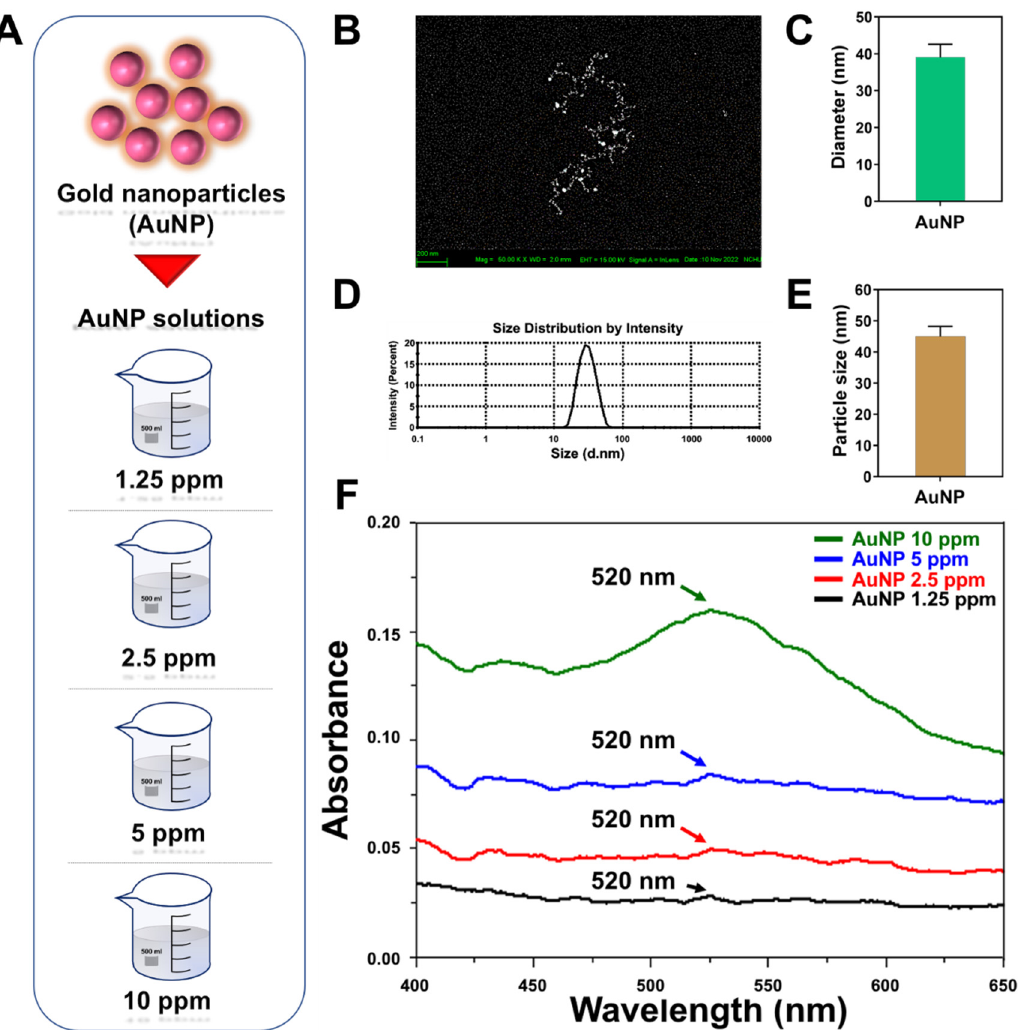
Figure 1. AuNP characterization. ( A ) The brief procedure to prepare various concentrations of AuNP solutions. The concentrations included 1.25, 2.5, 5 and 10 ppm. ( B,C ) The shape of the AuNPs was visualized by SEM, while the scale bar was set as 200 nm. The diameter of the AuNPs was quantified with Image J software, which was presented as 39 ± 3.5 nm. ( D,E ) The hydrodynamic size distribution intensity of the AuNPs was evaluated through DLS assay. The AuNP particle size was measured based on DLS assay, which was indicated as 45 ± 3.2 nm. ( F ) The as-prepared AuNP solutions with different amounts were subjected to UV-Vis assay. The spectra demonstrated the wavelength at 520 nm with the presence of AuNPs, while a higher concentration of AuNPs led to a stronger absorbance peak. The above results are exhibited as one of three independent experiments.